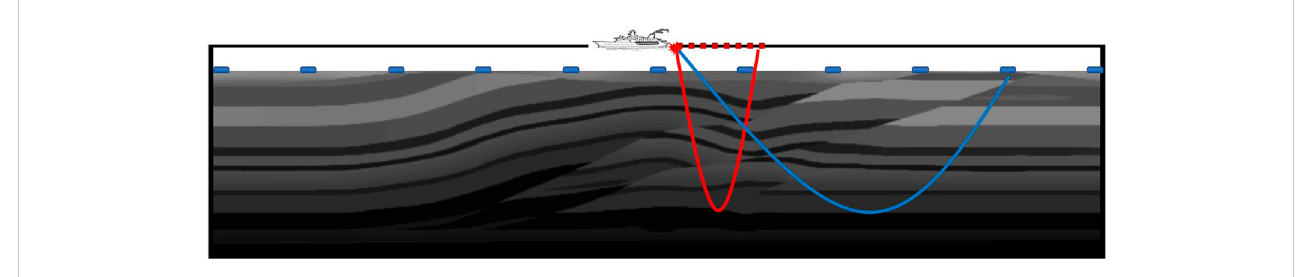
FIGURE 1 CombinedtowedstreamerandOBSacquisitiongeometry.Thereddotsontheseawatersurfaceindicatethetowedstreamerhydrophones,andtheblue squares on the sea fl oor indicate the OBS. The solid red line indicates the wave path of the towed streamer, and the solid blue line indicates the wave path of the